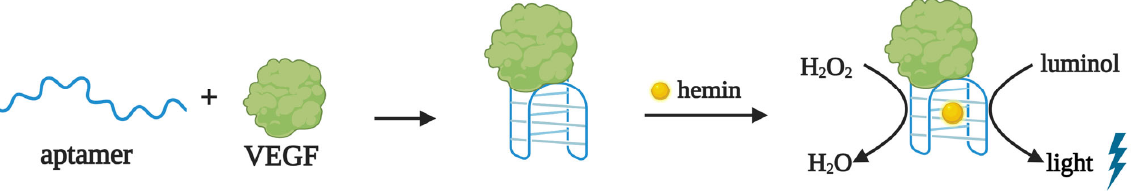
Figure 3. Chemiluminescent VEGF detection based on the peroxidase-mimicking activity of the hemin and G-quadruplex aptamer complex [17]. Target binding induces quadruplex structure formation in the VEGF aptamer. The resulting aptamer–target complex binds hemin and catalyzes the oxidation of luminol in the presence of hydrogen peroxide.